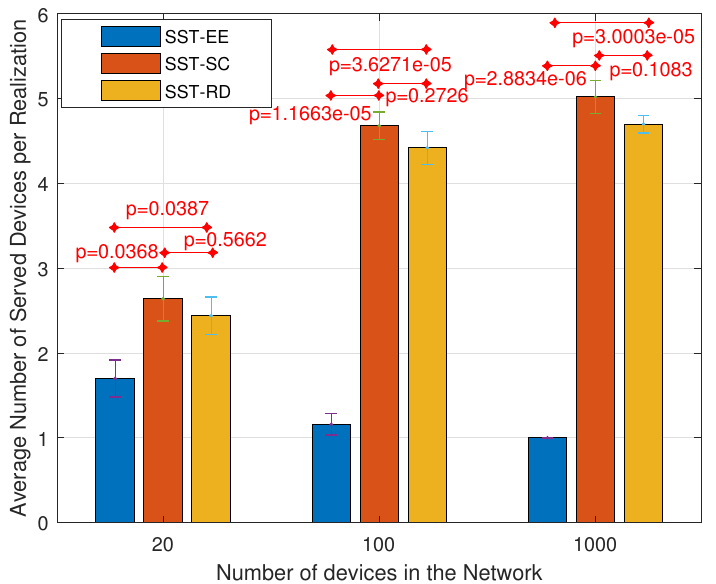
Figure 12. Variation in the average number of served devices per realization considering the SSS.